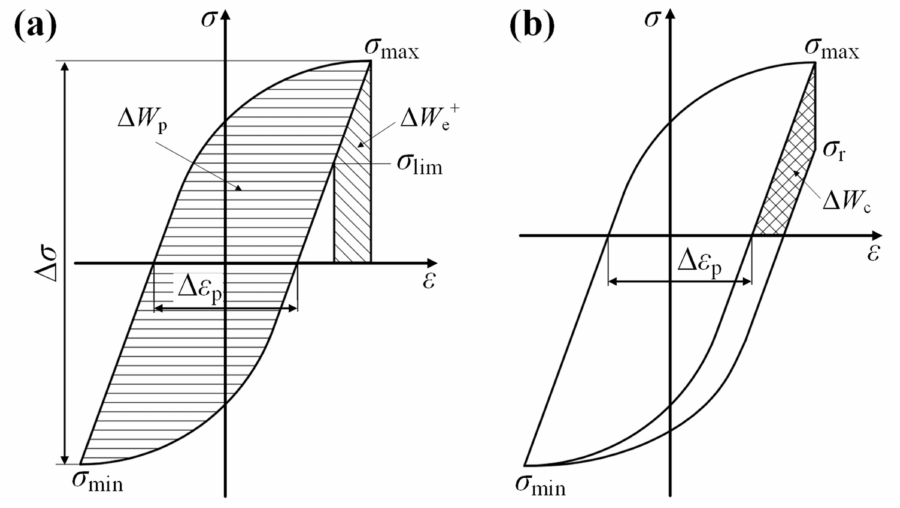
Figure 14. Hysteresis loop and strain energy density for ( a ) continuous fatigue and ( b ) fatigue with tensile-hold.